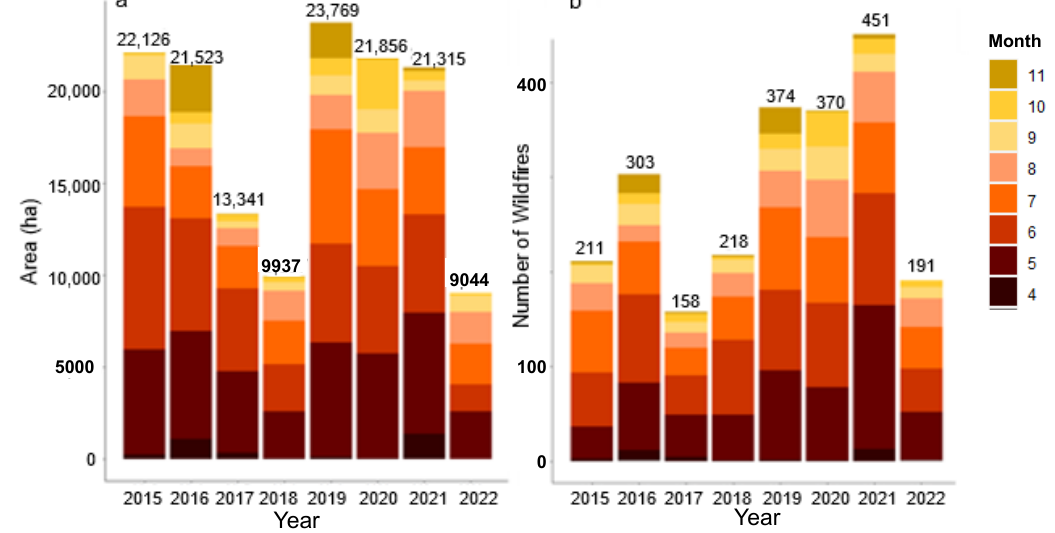
Figure 10. Total burned area ( a ) and number of wildfires ( b ) by month and